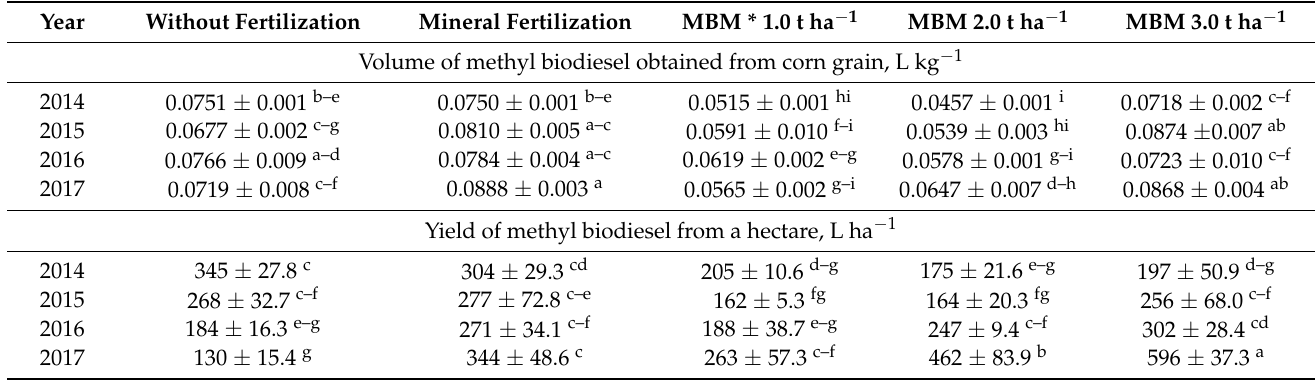
Table 10. Interaction between the years and treatments for volume of methyl biodiesel obtained from corn grain and yield of methyl biodiesel from a hectare (mean value and standard deviation).